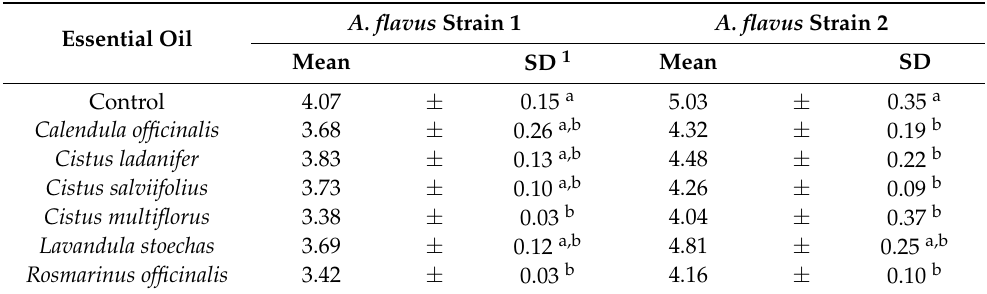
Figure 1. Growth of Aspergillus flavus strain 1 in PDA medium after 10 days of incubation in the presence of different essential oils. Table 4. Growth rate (mm/day) of A. flavus strains 1 and 2 that produce aflatoxins B 1 and B 2 obtained over 10 days of incubation at 25 ◦ C.